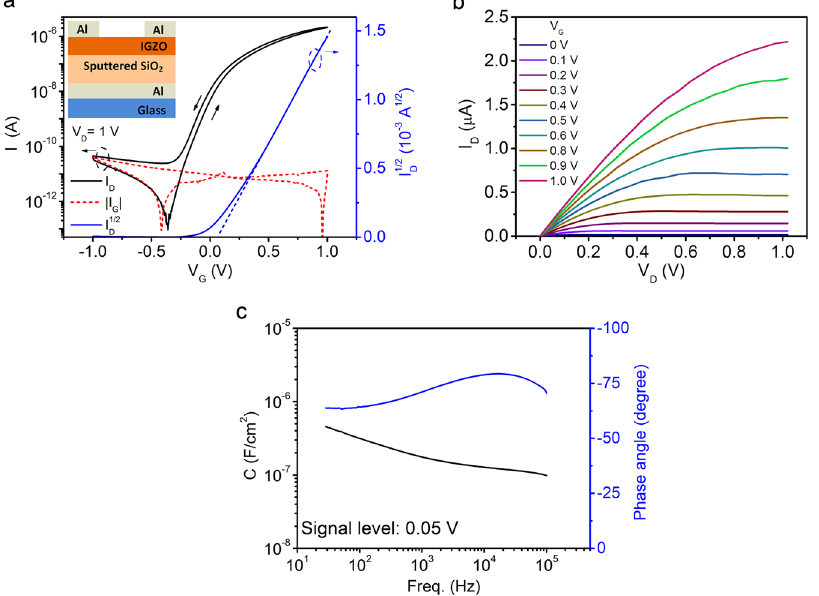
Figure 1. Characteristics of EDL TFTs. ( a ) Transfer characteristics of the TFT gated with SiO 2 deposited at 85 W and an Ar pressure of 5 × 10 − 3 mbar on a glass substrate. The schematic cross-sectional view of the device is shown in the inset. The channel width and the channel length are 1.5 mm and 80 μ m, respectively. ( b )